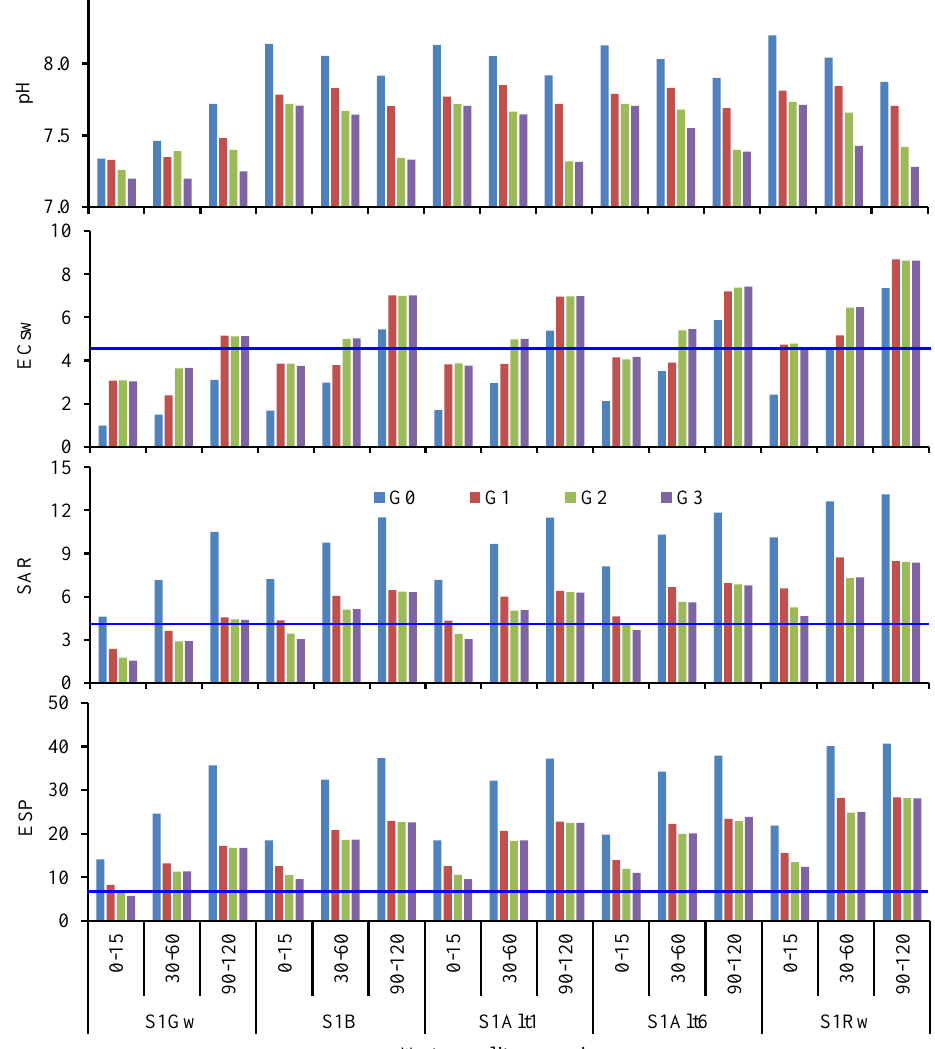
Figure 1. Average values of pH, EC sw , SAR, and ESP in the calcareous soil (S1) under long-term (2018–2050) irrigation of wine grapes with different water qualities (recycled water, RW; good water, GW; blending RW and GW in a 1:1 ratio, B; RW and GW used in monthly cycles, Alt1; RW and GW used in half-yearly cycles, Alt6) and annual gypsum additions of 0 (G0), 1.7 (G1), 4.3 (G2), and 8.6 (G3) t/ha.